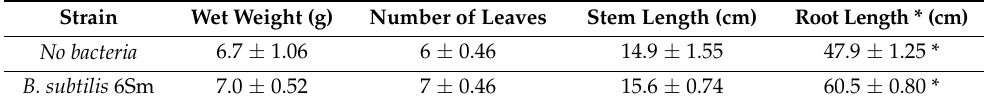
Table 5. Plant-growth-promoting